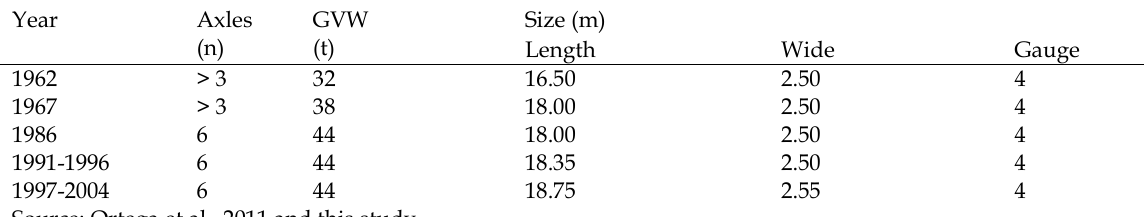
Table 2. Evolution of the Spanish legislation regarding maximum GVW